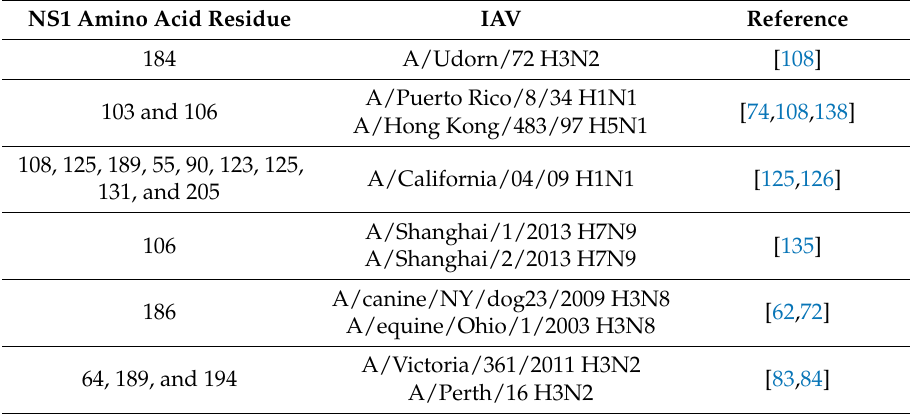
Table 2. The IAV NS1 amino acid residues that are involved in the interaction with